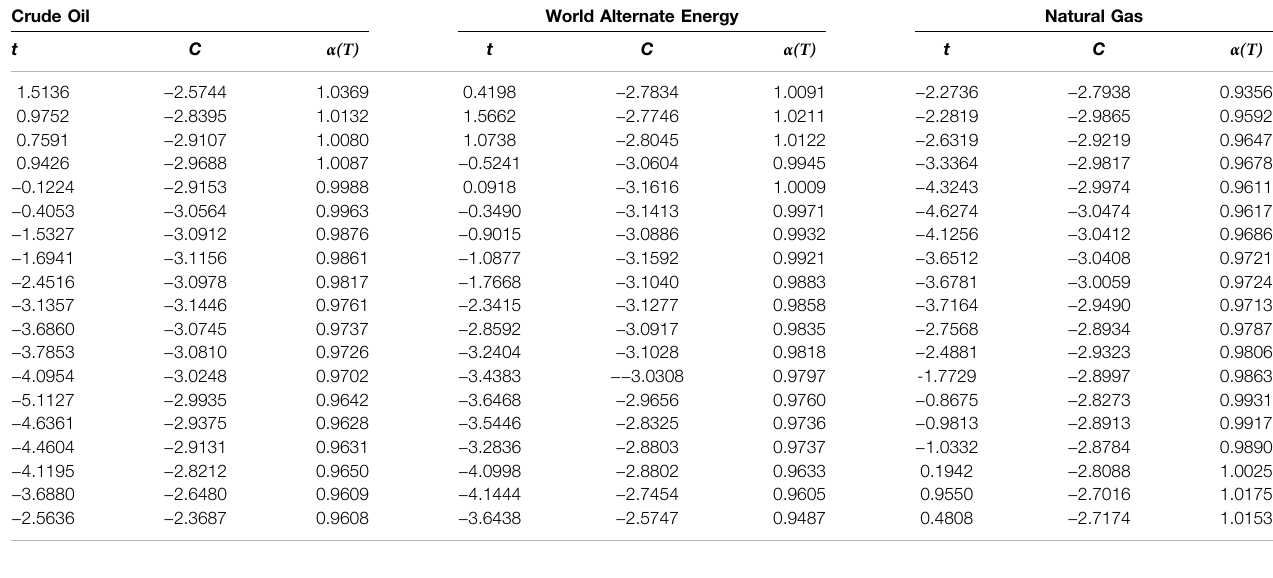
TABLE 4 | Quantile unit root tests, Energy Funds. Crude Oil World Alternate Energy